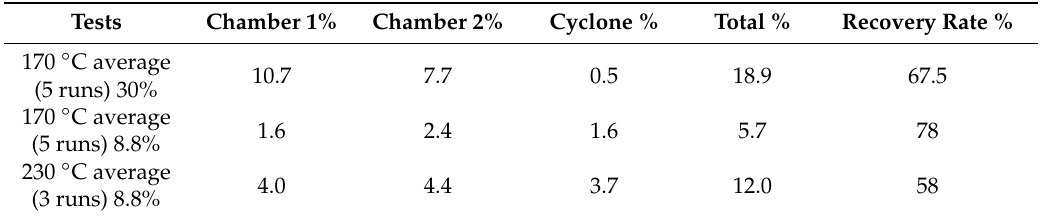
Table 5. Deposition percentages (relative to the feed) in each part of the four-inch configuration. Tests Chamber